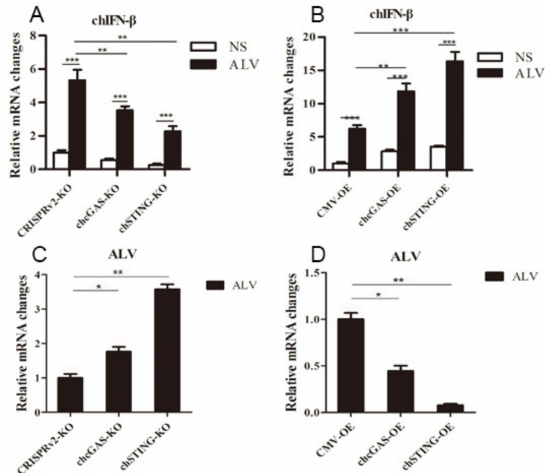
Figure 11. ALV-A replications in chGAS and chSTING stable HD11 cells. HD11 KO and OE stable cells in 12-well plate (2 × 10 5 cells / well) were infected with ALV-A (0.01 MOI) for 14 h and 14 h, respectively. The cells were analyzed by RT-qPCR for both cellular gene transcriptions ( A,B ) and viral gene transcriptions ( C,D ). The signs “*”, “**”, “***” denote p < 0.05, p < 0.01 and p < 0.001,